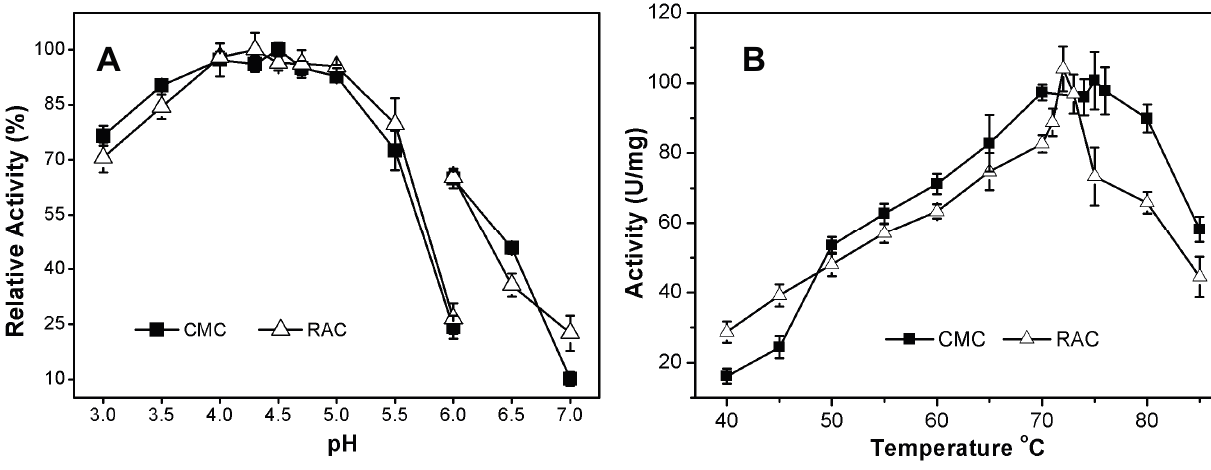
Figure 3. Effects of pH ( A ) and temperature ( B ) on the activity of AcCel12B. ( A ) 50 mM sodium acetate buffer (pH 3.0–6.0), 50 mM sodium phosphate buffer (pH 6.0–7.0); ( B )